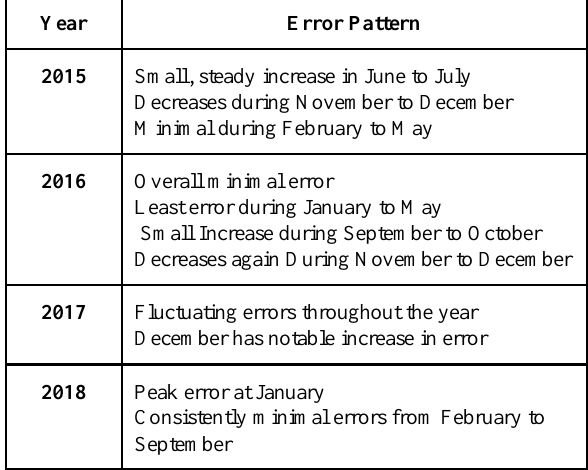
Table 5. Summary of the observed CT3 error patterns per year.